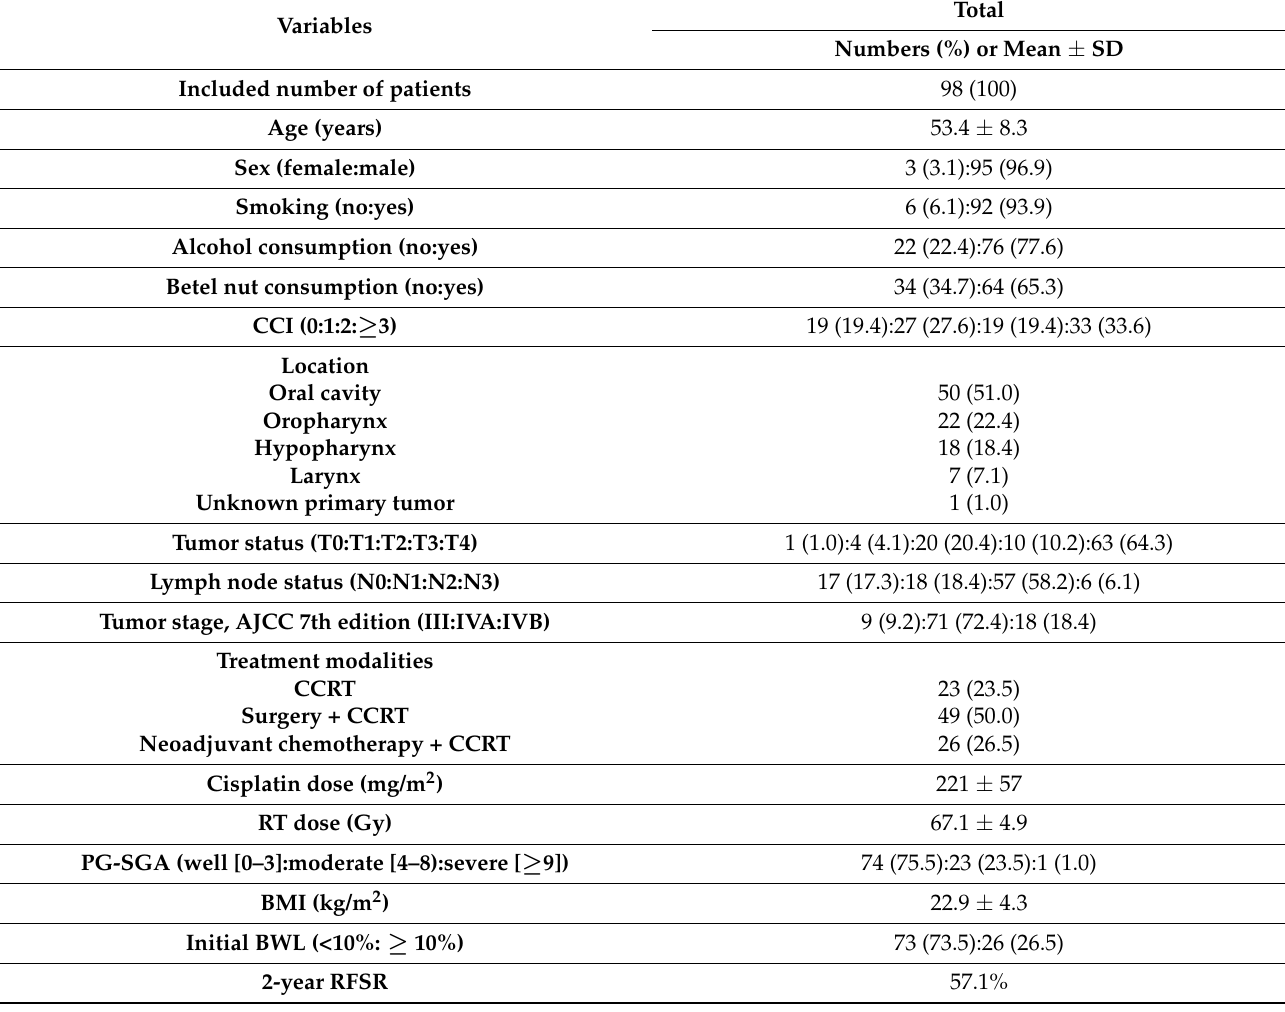
Table 1. Baseline characteristics of patients with locally advanced head and neck cancer (LAHNC) undergoing concurrent chemoradiotherapy